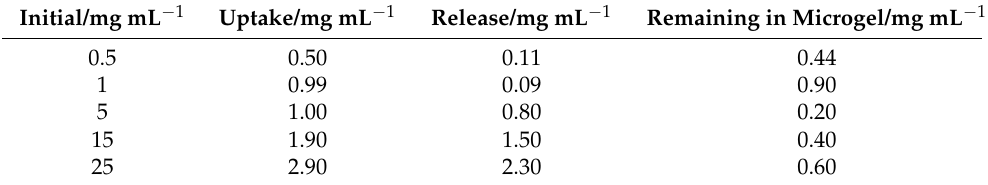
Figure 8. Measurement of the temperature-dependent release (40°C) of CBD in ethanol. The legend displays the initial CBD concentration. The extinction coefficient at λ = 278nm, determined during the initial CBD characterization, was used to calculate the efficiency of the release. Table 1. Initial CBD concentration used for the incorporation of CBD into the microgel network at 20°C and a summary of the calculated concentrations of the ingested, released and remaining CBD concentration at 40°C in EtOH in the microgel particles obtained from the calculation using the UV/Vis